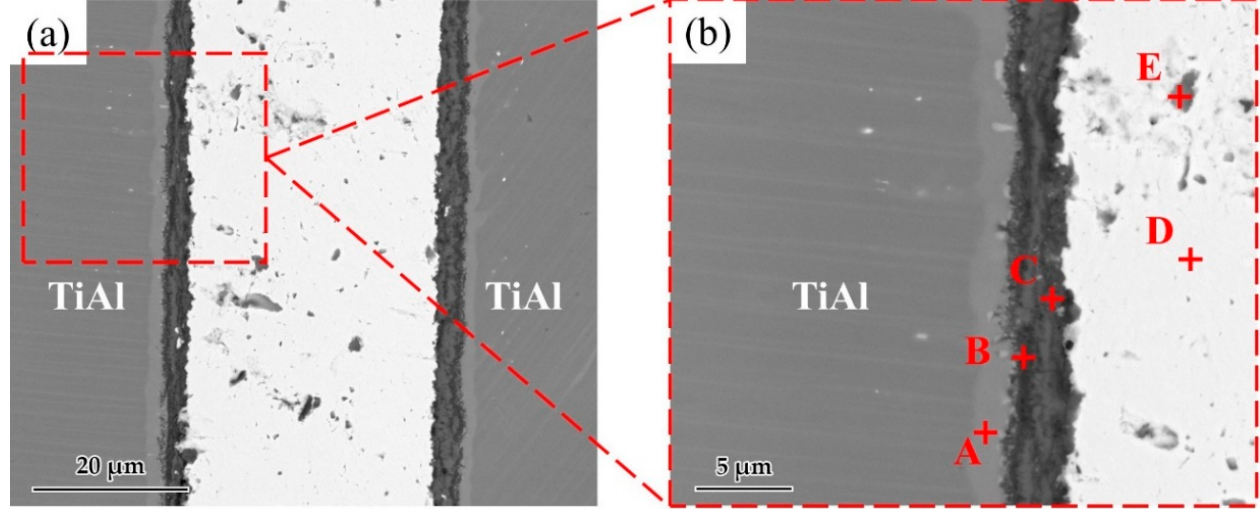
Figure 6. ( a ) Microstructure of the joint brazed at 1020 °C for 20 min. ( b ) Enlarged image of the interface. Table 4. EDS result of each spot in Figure 6 (at. %).